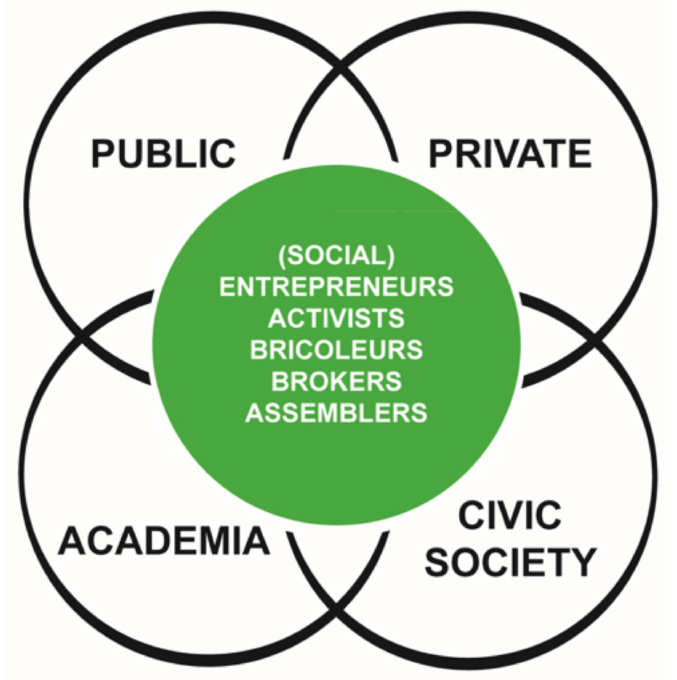
Figure 1. Penta Helix multi-stakeholder framework